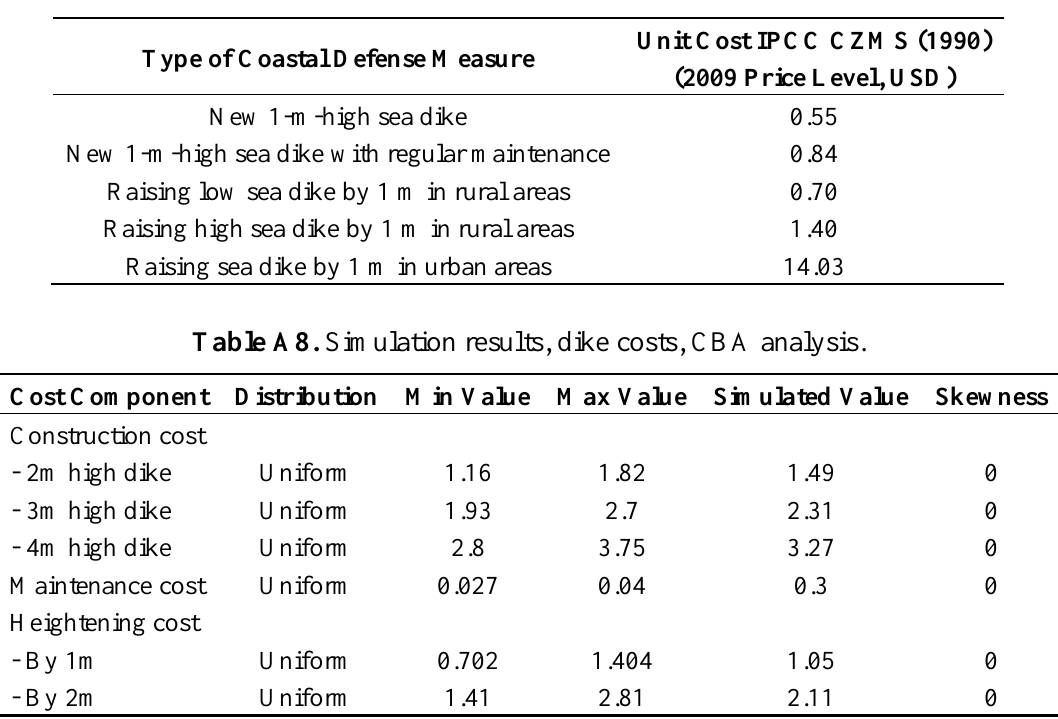
Table A7. Unit cost prices of dike heightening (USD/km). Source: Hillen et al. [10].